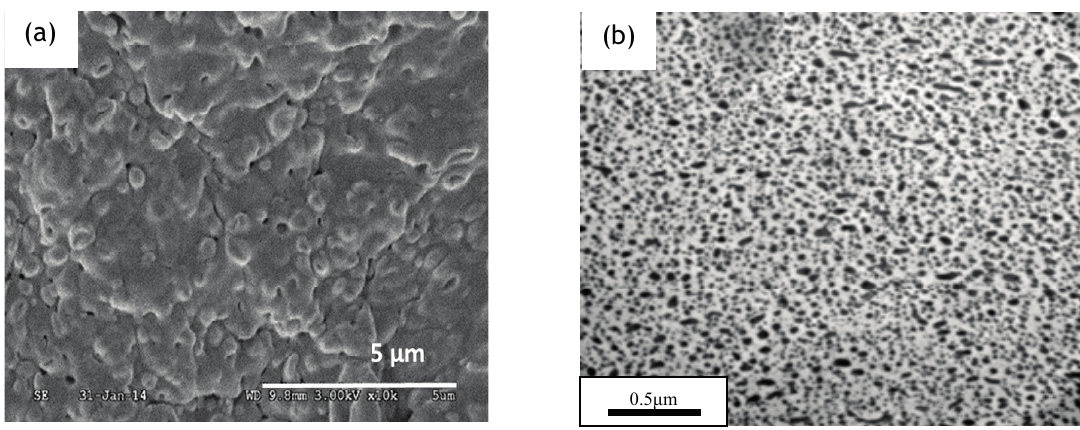
Figure 5. Examples of ( a ) SEM micrograph of PLA–PBAT (80–20) blends; Volume average diameter ( D v ) = 0.25 μ m and ( b ) TEM micrograph of PLA–PBAT–Joncryl (80–20–0.7); D v = 0.07 μ